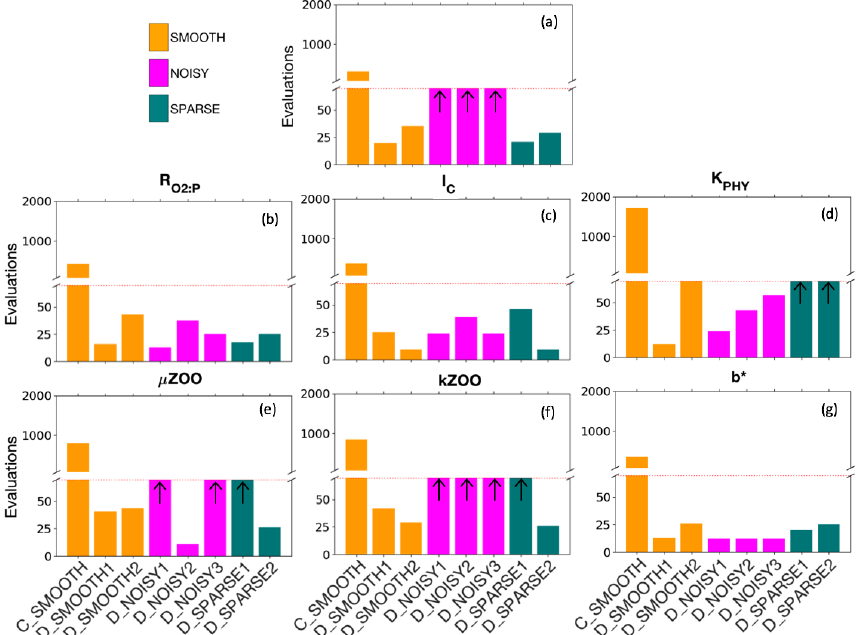
Figure 5. Number of evaluations required by the SMOOTH (orange), NOISY (magenta) and SPARSE (green) twin experiments to (a) reduce the global misfit to below noise levels (baseline misfit) and (b–g) successfully recover each parameter. The red dashed line shows the maximum number of evaluations allowed for DFO-LS experiments. Black arrows indicate (a) the baseline misfit was not reached, or (b– g) the parameter was not recovered in that optimisation experiment. Note that the number of evaluations required by CMA-ES in experiment C_SMOOTH always plotted above the break in the y axis. For further information see Table C2.